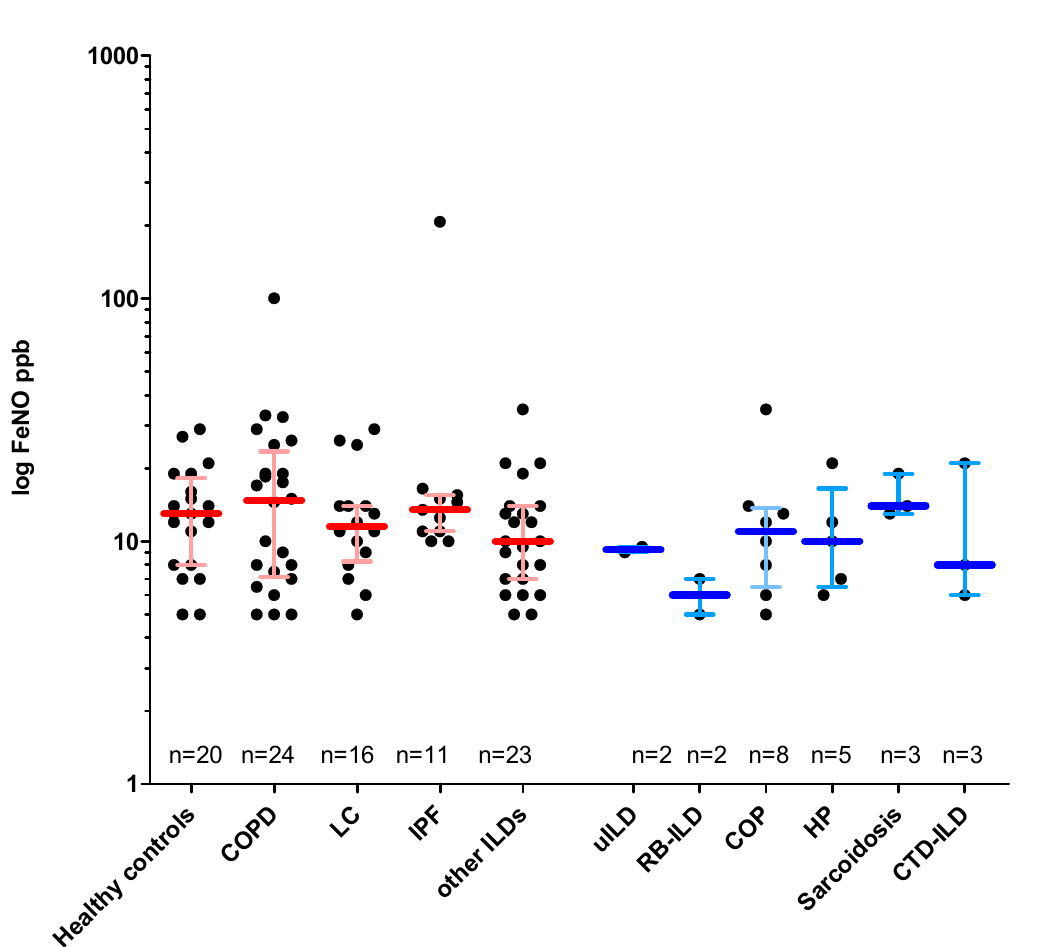
Figure 1. FeNO values in the different lung disease cohorts vs. healthy controls. Given are the median (horizontal bar) with interquartile range as well as single data (dots). uILD, RB–ILD, COP, HP, sarcoidosis and CTD–ILD have been summarized as “ILD” and are shown separately in blue on the right margin. Abbreviations: IPF: idiopathic pulmonary fibrosis, ILD: interstitial lung diseases, HP: hypersensitivity pneumonitis, COPD: chronic obstructive pulmonary disease, COP: cryptogenic organizing pneumonia, CTD–ILD: connective tissue disease-associated ILD, LC: lung cancer, NSIP: nonspecific interstitial pneumonia, RB–ILD: respiratory bronchiolitis ILD, uILD: unclassifiable ILD. If data not available from all patients, the number(s) is specified.